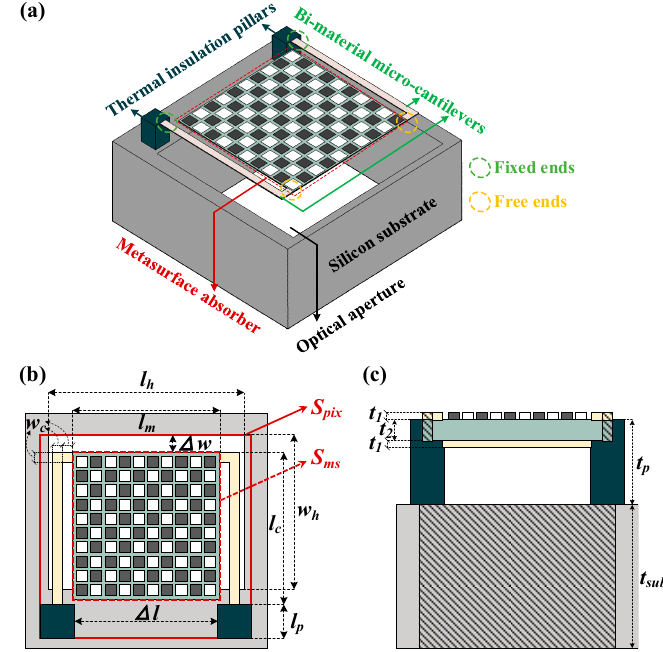
Figure 1. ( a ) 3D view of the detector with bi-material micro-cantilevers and metasurface absorber, fabricated on silicon substrate with optical aperture. ( b ) Top view and ( c ) side view of the